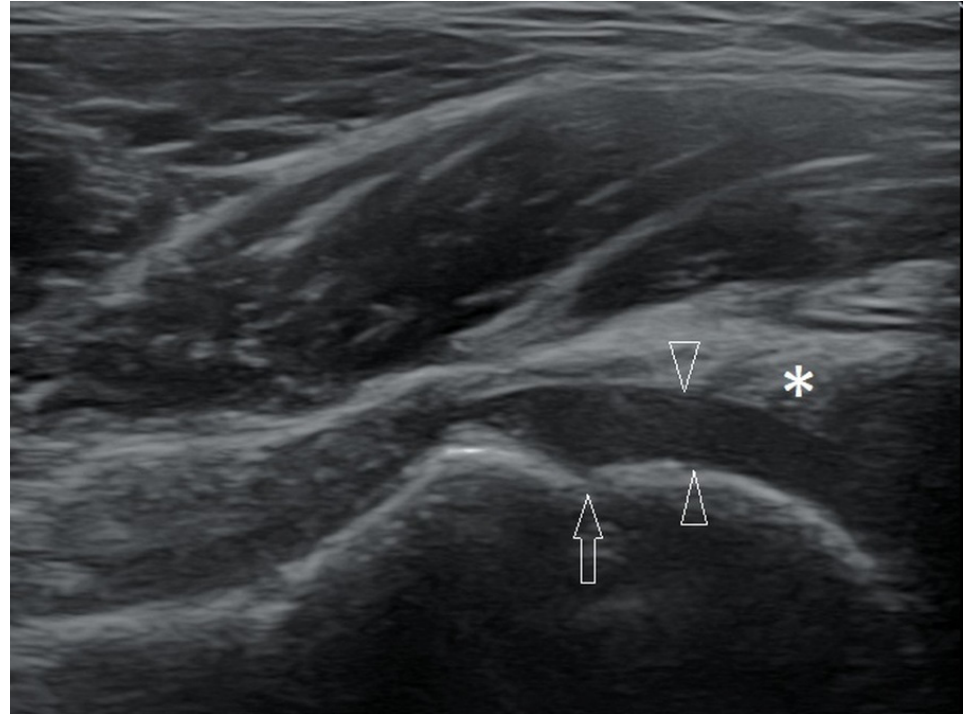
Figure 1. Longitudinal scan of the hip joint of a 5-year-old girl. Between the arrowheads—hyaline cartilage of the femoral head; arrow—level of the growth plate of the femoral head; asterisk—the labrum. Linear probe 3–12 MHz.